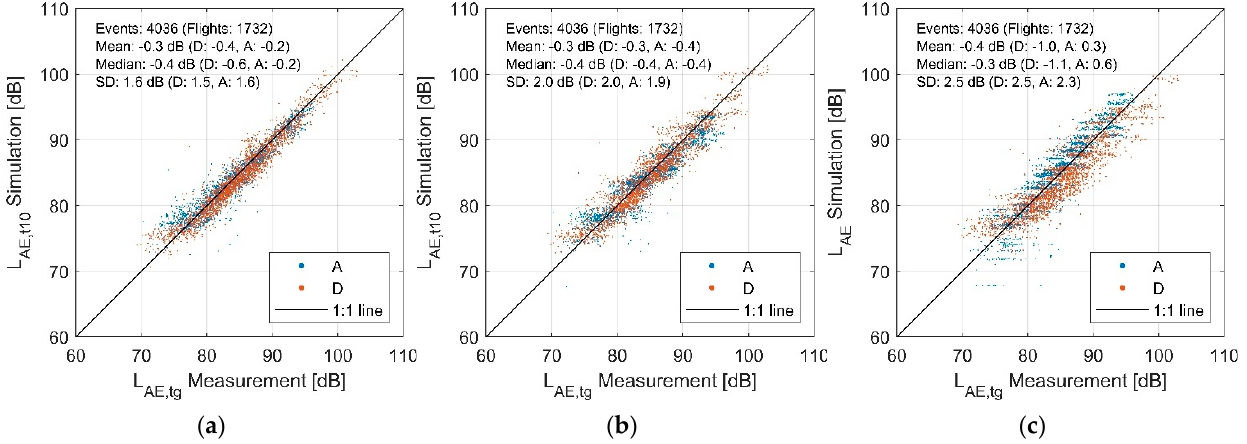
Figure 4. Scatter plots of simulation vs. measurements for aircraft with FDR data in the close range to the airports (ZRH and GVA combined), grouped by procedure (D: Departure, A: Approach, SD: Standard deviation). ( a ) sonAIR, ( b ) FLULA2, ( c ) AEDT.